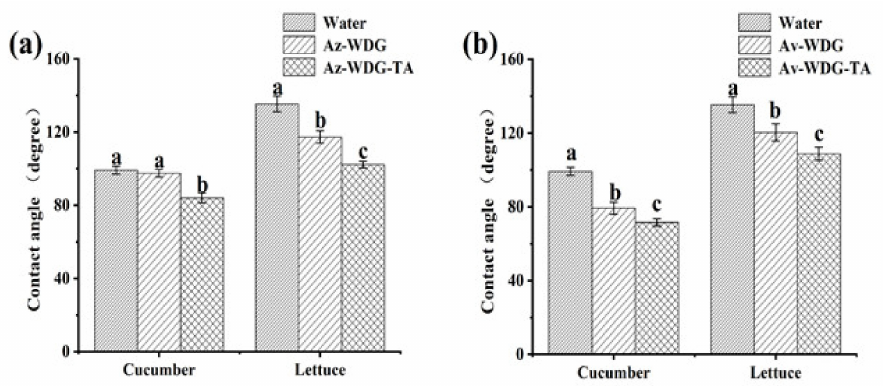
Figure 5. Contact angles of ( a ) Az-WDG, Az-WDG-TA and ( b ) Av-WDG, Av-WDG-TA on di ff erent foliage. Based on a one-way ANOVA using the S-N-K test, values with di ff erent letters are significantly di ff erent ( p < 0.05).